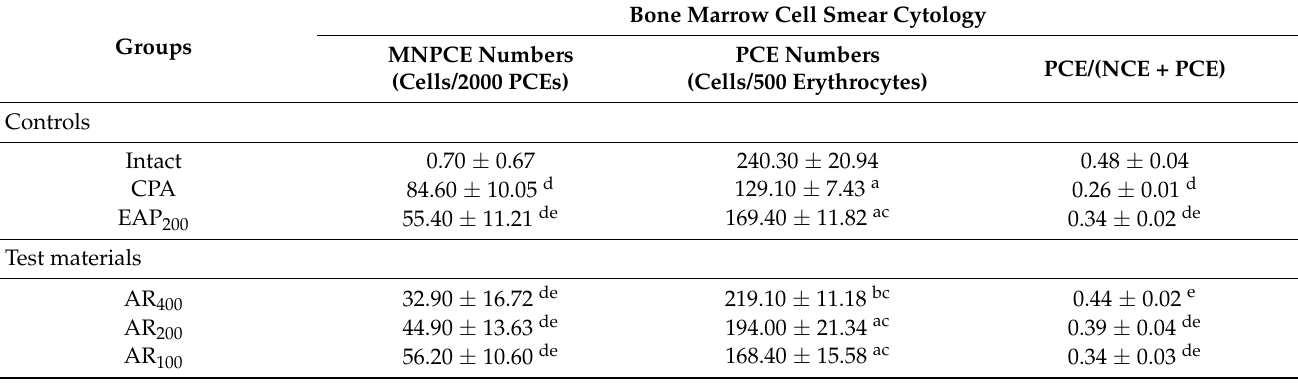
Table 2. Results of the micronucleus assay of bone marrow cells collected from individual intact or CPA-induced immunosuppressed mice at sacrifice.